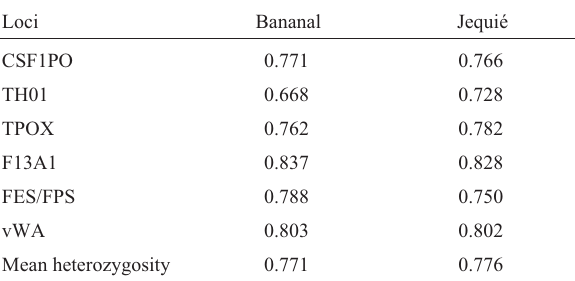
Table 2 - Genic diversity (H S ) for the loci analyzed in the Bananal and Jequié populations of African descent.